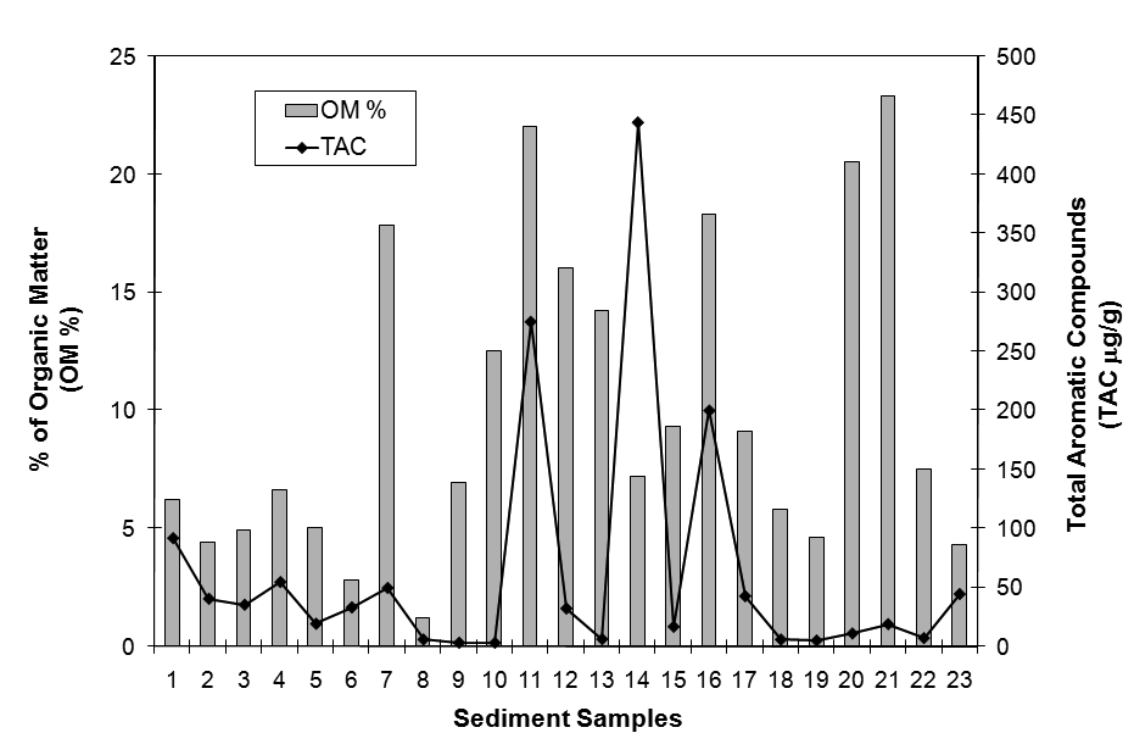
Fig. 7 – ETSA and ESTE enzymatic activity concentrations.